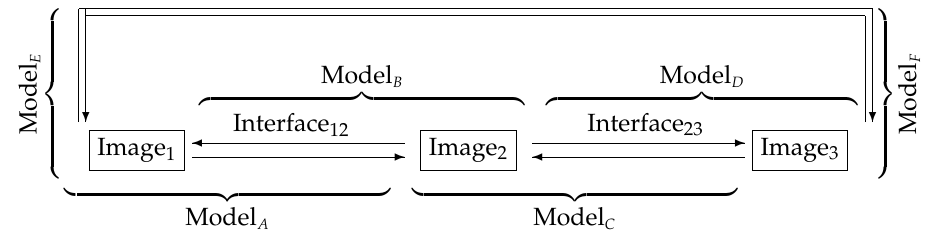
Figure 10. Illustration of the concept of “model-triad”.